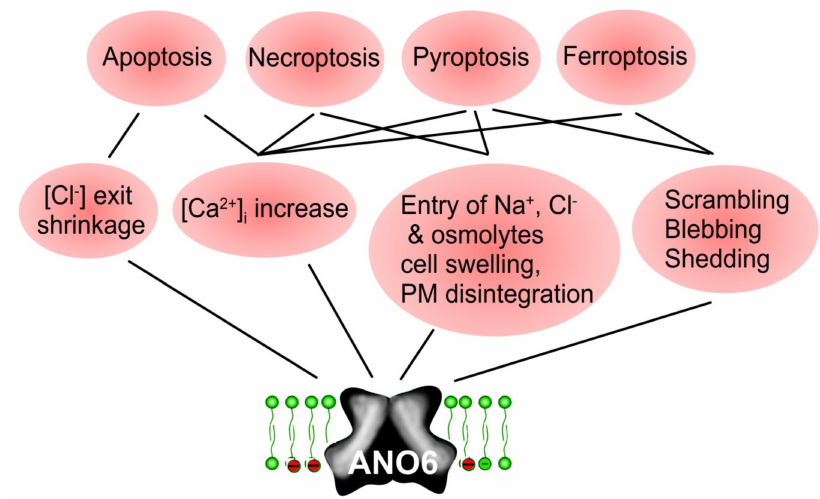
Figure 6. ANO6-induced cell death. Scheme summarizing the contribution of ANO6 to different regulated cell death pathways such as apoptosis, necroptosis, pyroptosis, and ferroptosis. Anoctamins may contribute to regulated cell death by cell shrinkage (apoptosis), increase in compartmentalized intracellular Ca 2+ (all cell death pathways), or cell swelling, scrambling, blebbing, and membrane disintegration (ferroptosis, pyroptosis). For further details and references, see main